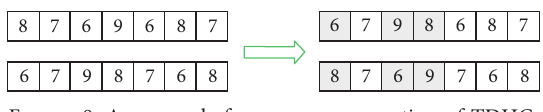
Figure 9: An example for mutation operation of TDHC.